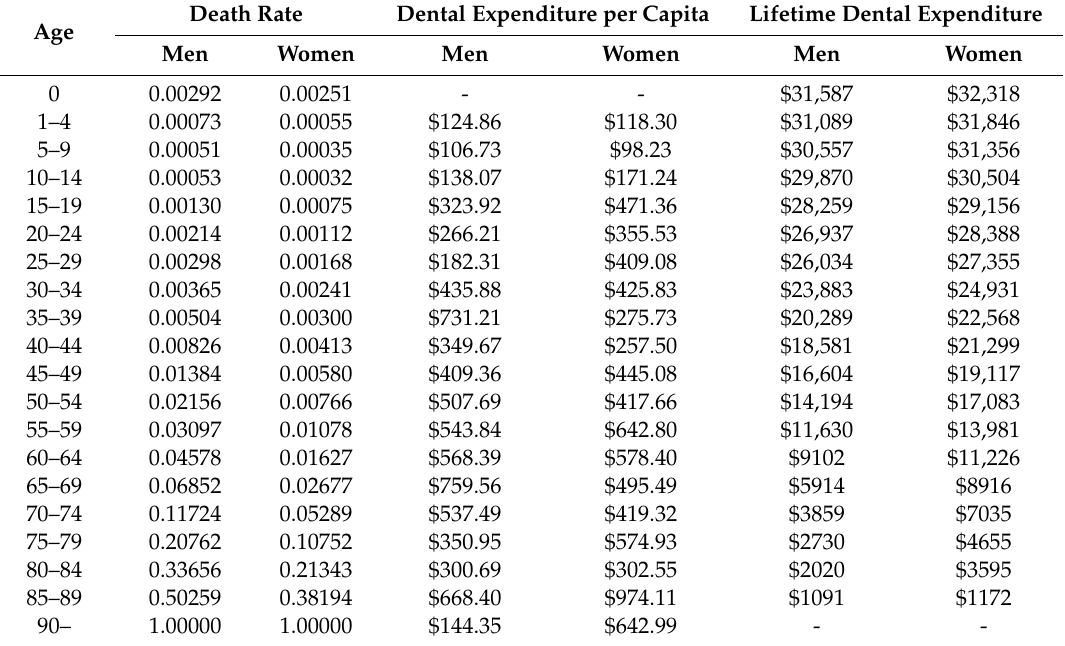
Table 1. Per capita death rate, dental expenditure, and lifetime dental expenditures of average life table men and